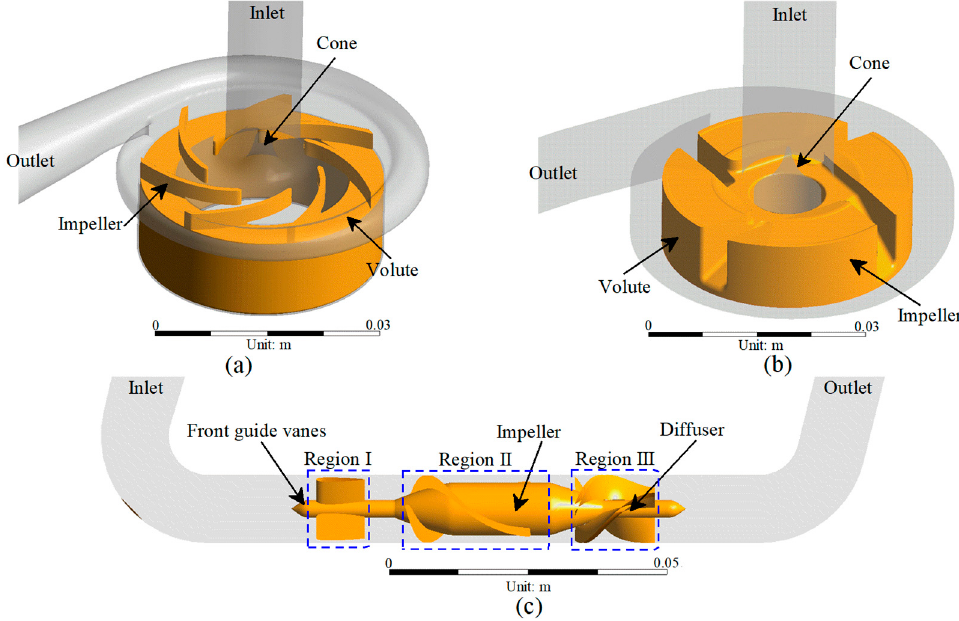
Figure 1. 3D model of the studied VADs: ( a ) CH-VAD; ( b ) HVAD; and ( c ) HM II.